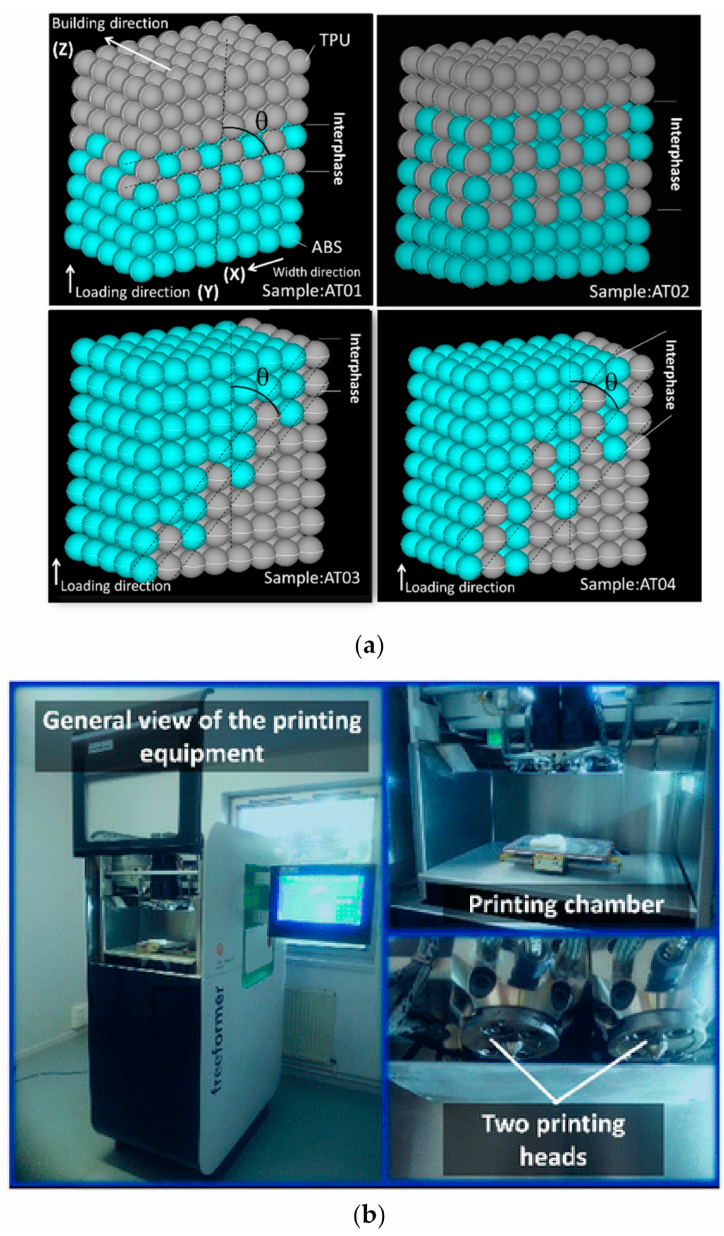
Figure 1. Printing configurations in droplet-based additive manufacturing of a polymer composite. ( a ) Illustration of the printing configurations AT01: one intertwining droplet, θ = 90 ◦ ; AT02: two intertwining droplets, θ = 90 ◦ ; AT03: one intertwining droplet, θ = 60 ◦ ; AT04: two intertwining droplets, θ = 60 ◦ . ( b ) Snapshot of the droplet-based additive manufacturing